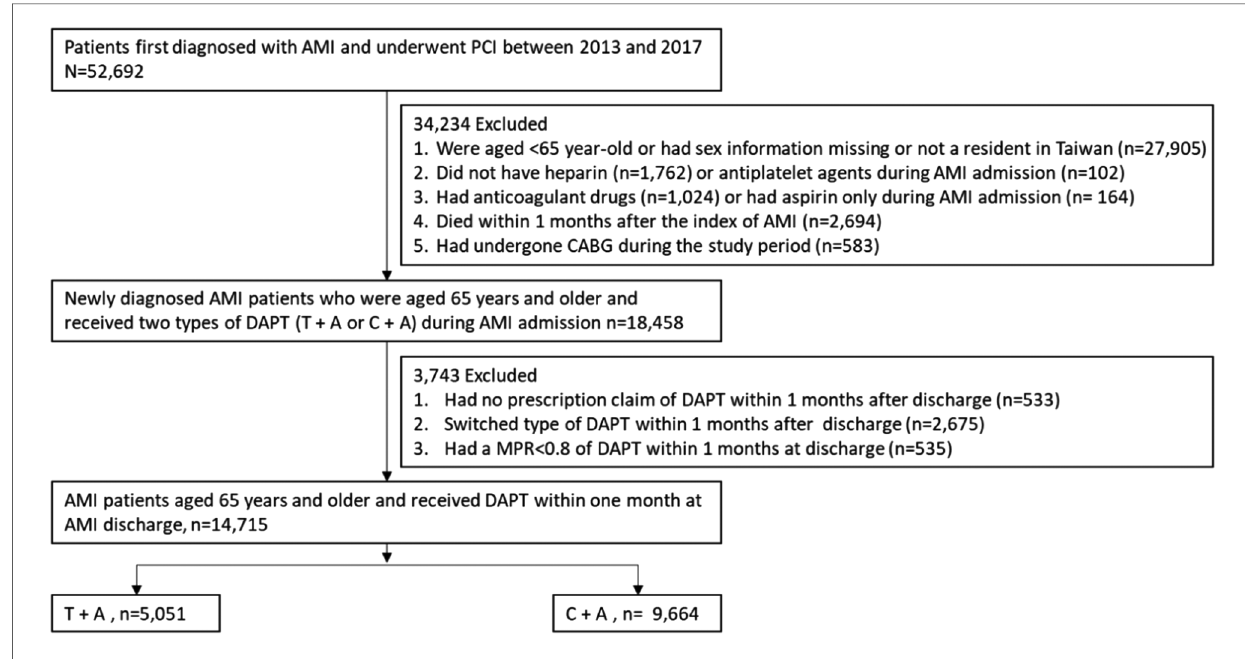
FIGURE 1 Patient selection process. A, aspirin; AMI, acute myocardial infraction; C, clopidogrel; CABG, coronary artery bypass graft; DAPT, dual antiplatelets therapy; MPR, medication possession ratio; PCI, percutaneous coronary intervention; T,